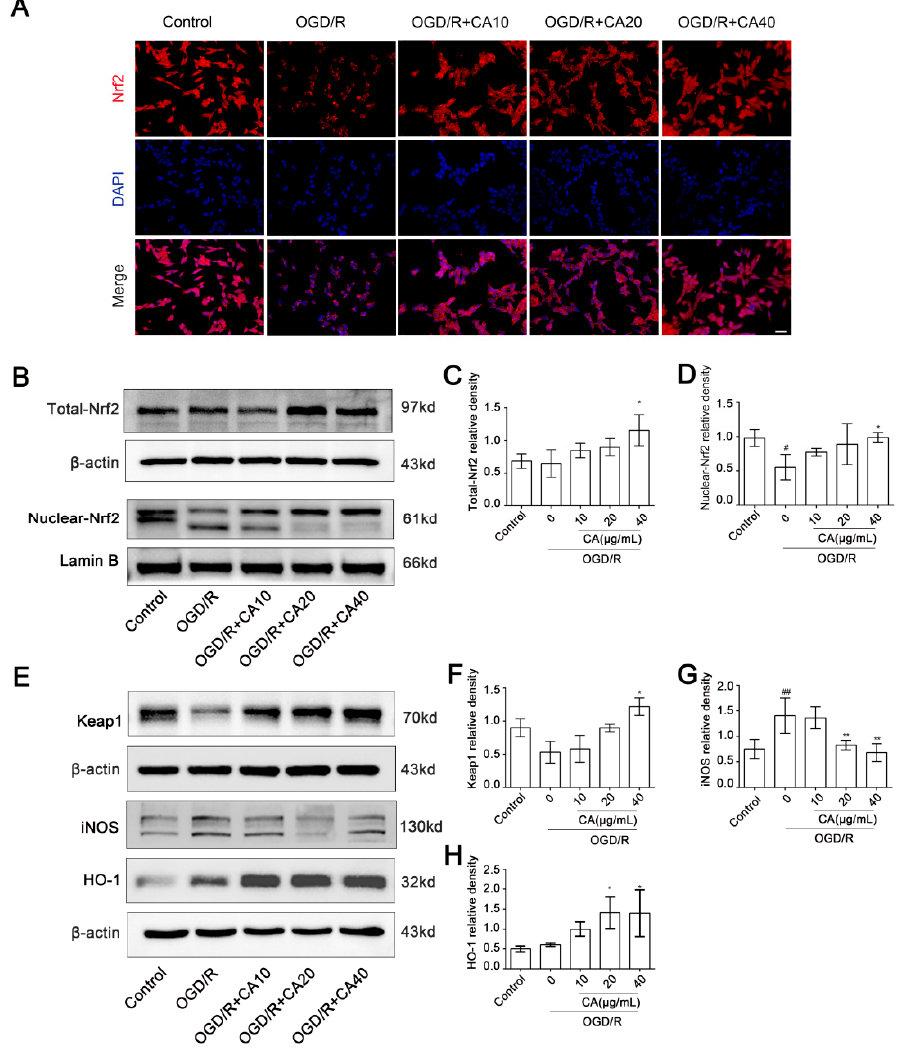
Figure 3. Nrf2 nuclear translocation was enhanced by CA in OGD/R-insulted SH-SY5Y cells. ( A ) SH-SY5Y cells in different groups were first stained with anti- Nrf2 antibody (red) and then counterstained with DAPI (blue) (40 × ). ( B – D ) The expression of nuclear Nrf2 and total Nrf2 were determined by western blot. ( E – H ) Chebulinic acid promoted the activation of Nrf2-ARE pathways. Western blot analysis was carried out with specific antibodies for detecting the activation of Keap1, iNOS, HO-1. Results are expressed as mean ± SD. # p < 0.05, and ## p < 0.01 compared with the control. * p < 0.05, and ** p < 0.01 versus OGD/R